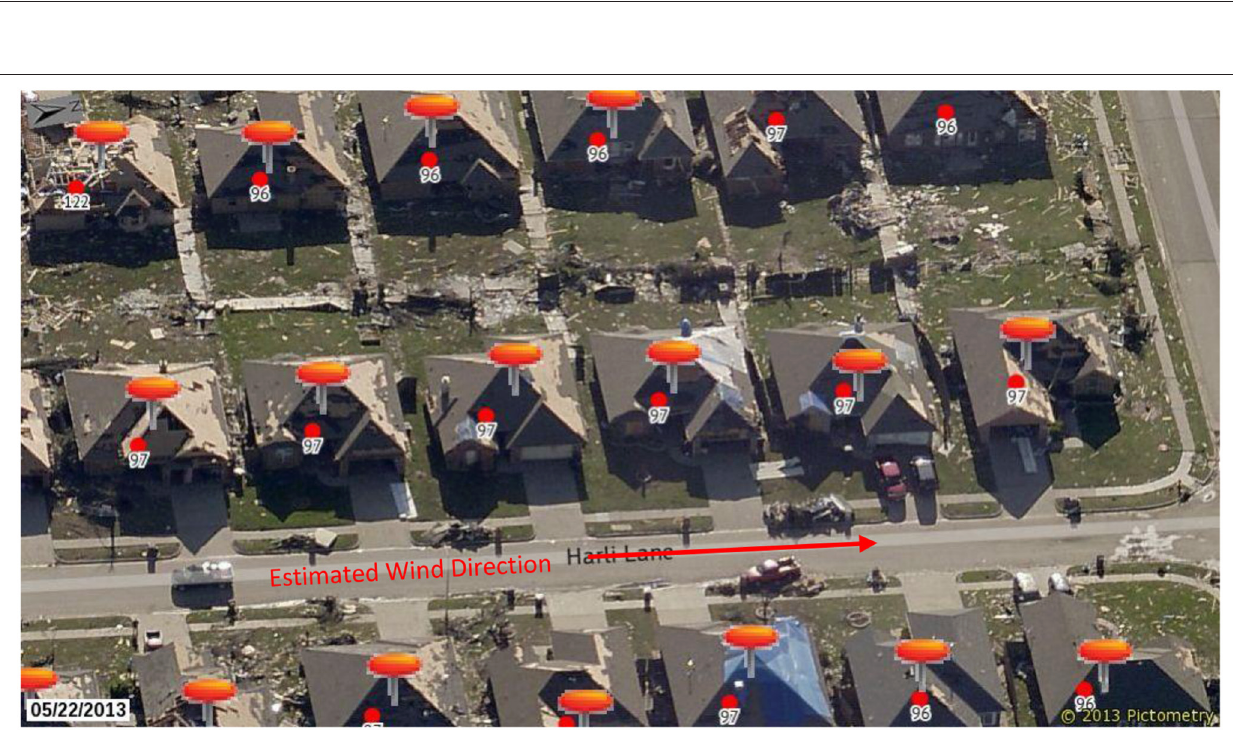
Frontiers in Built Environment |